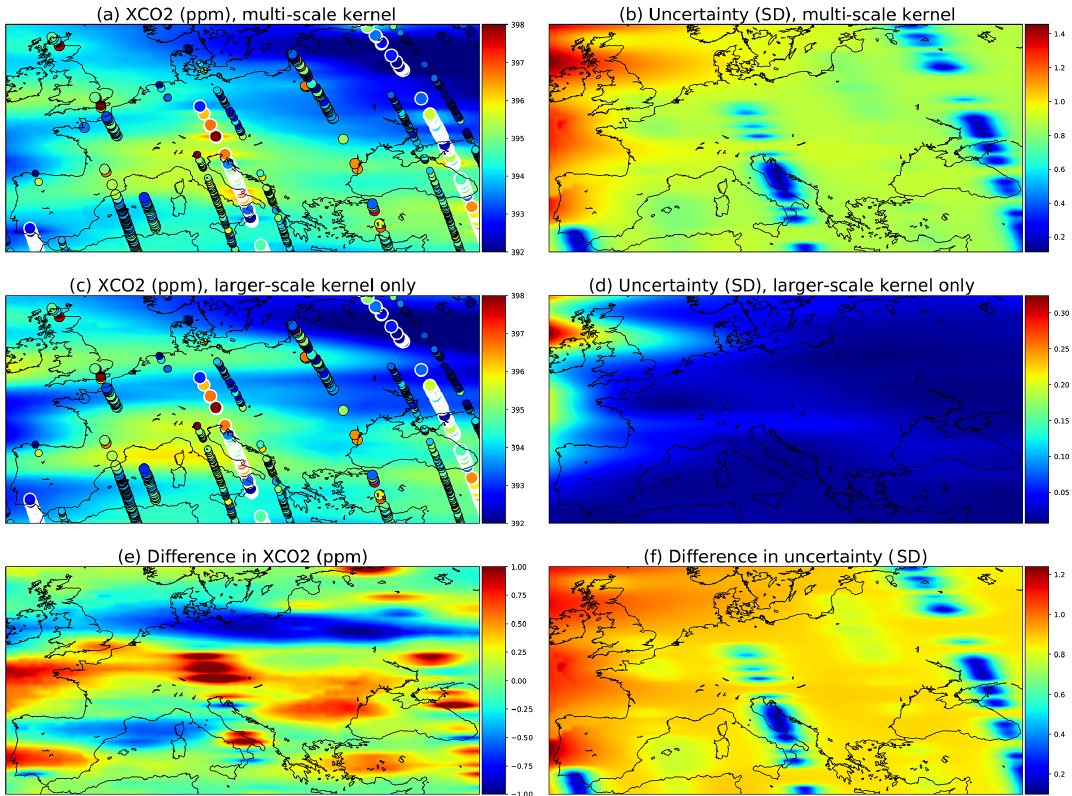
Figure 11. Comparison of a multi-scale kernel with the two components described in Sect. 4.5 and a single component kernel defined by the parameters of the exponential kernel. These parameters were given in Table 4. The observations used are the same and are shown in panels (a) and (c) as circles. The large ones with white borders are observations from the present day, 15 September 2014; medium circles are observations from the 14th and 16th, and small circles are from the 13th and 17th.